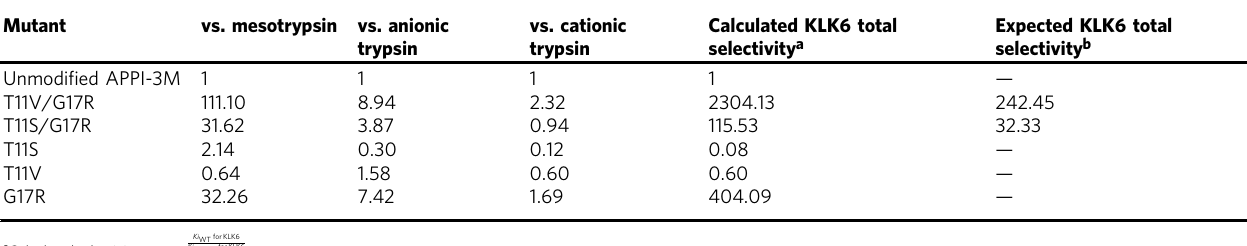
a Calculatedselectivity